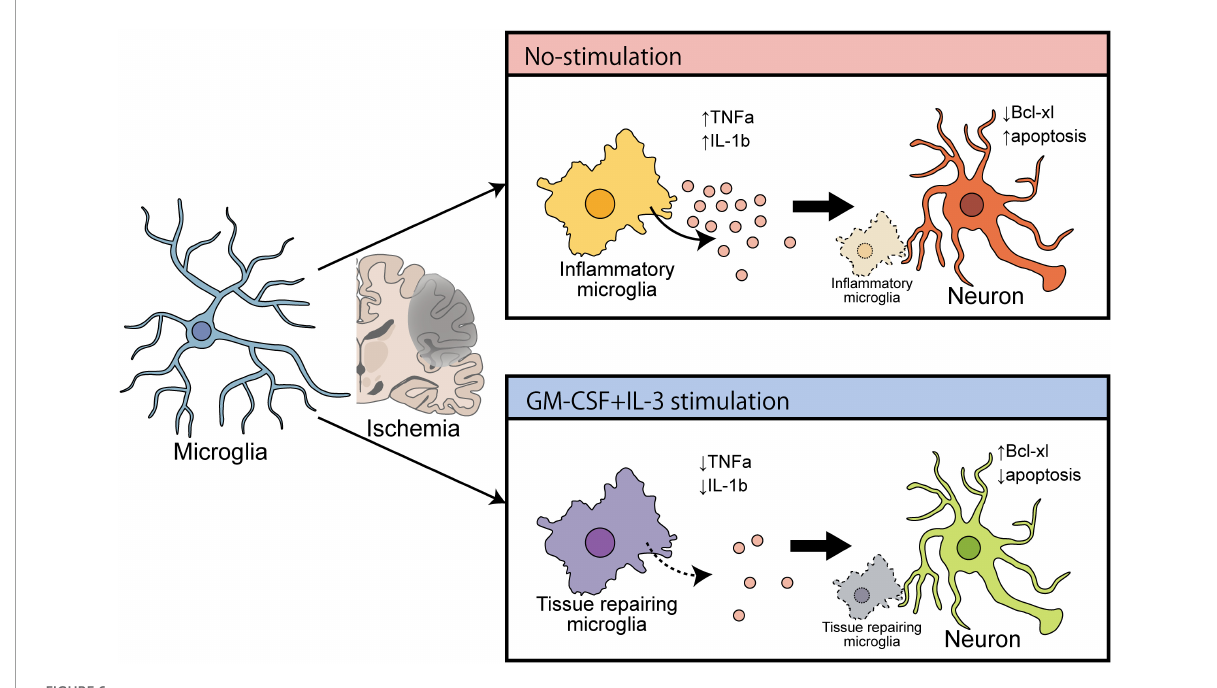
FIGURE6 Schematic diagram showing the ameliorating effect of cytokines (GM-CSF and IL-3) on cerebral ischemia that induces brain recovery by converting inflammatory microglia into a tissue repair